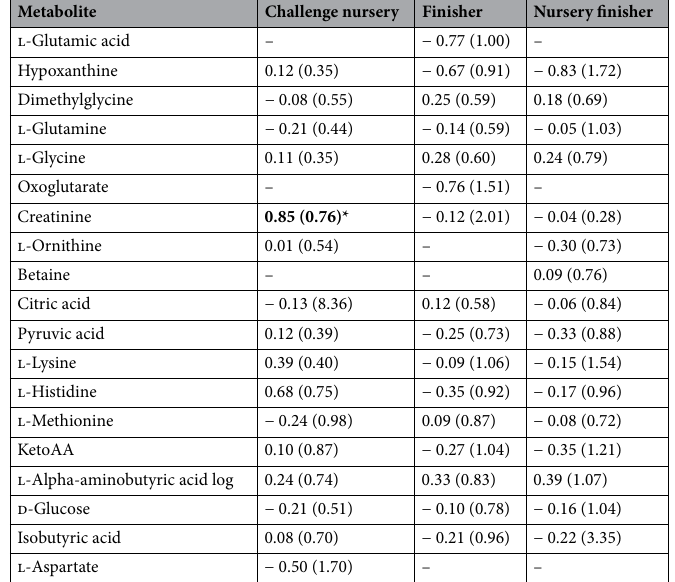
Table 6. Estimates of genetic correlations (SE in parentheses) between the most heritable metabolites and mortality in the challenge nursery, finisher, and across the nursery and finisher. Significance of genetic correlations are indicated in bold as: *, corresponding to P ≤ 0.05. “–” indicates not